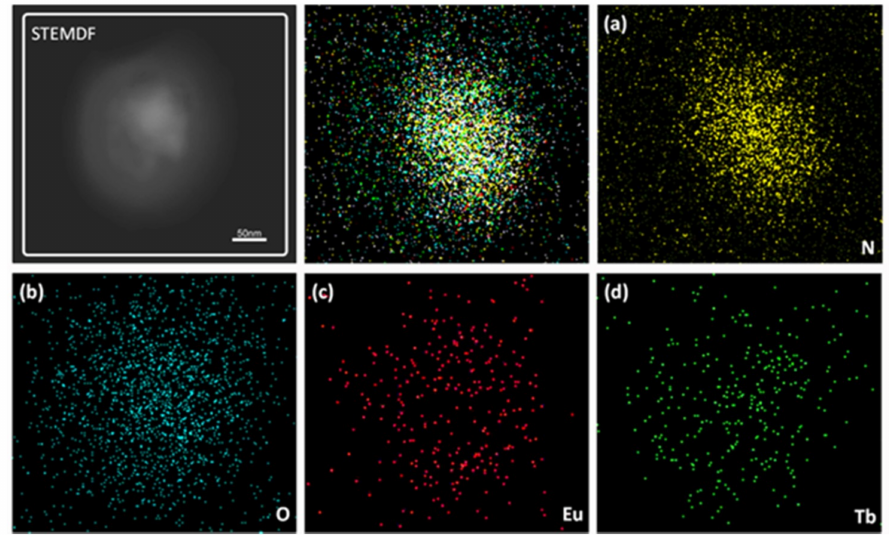
Figure 6. STEM dark-field (DF) image, ( a – d ) elemental mapping of N, O, Eu, Tb elements of BCPs-Ln 3+ -Phen,